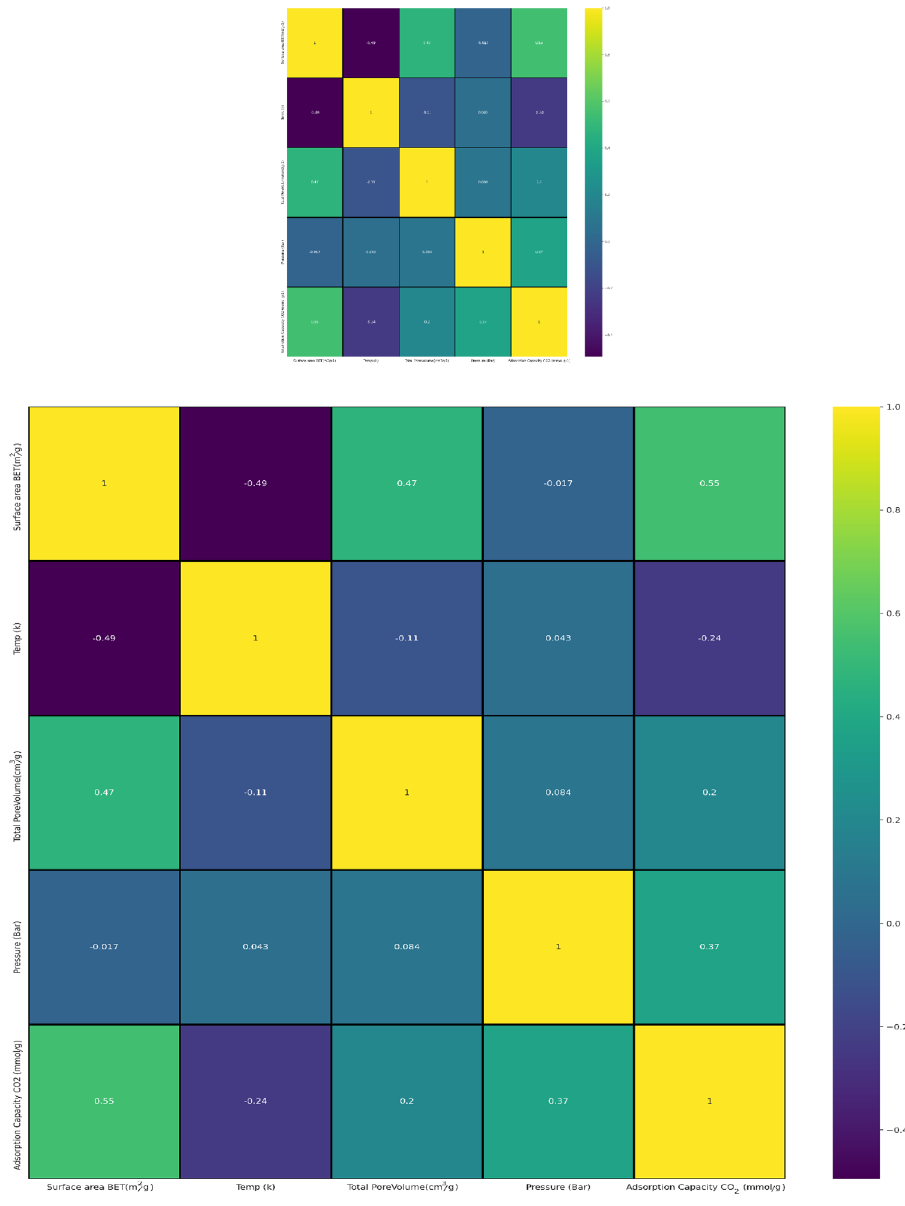
Figure 3. Pearson correlation matrix between any two properties, and between adsorption efficiency and each